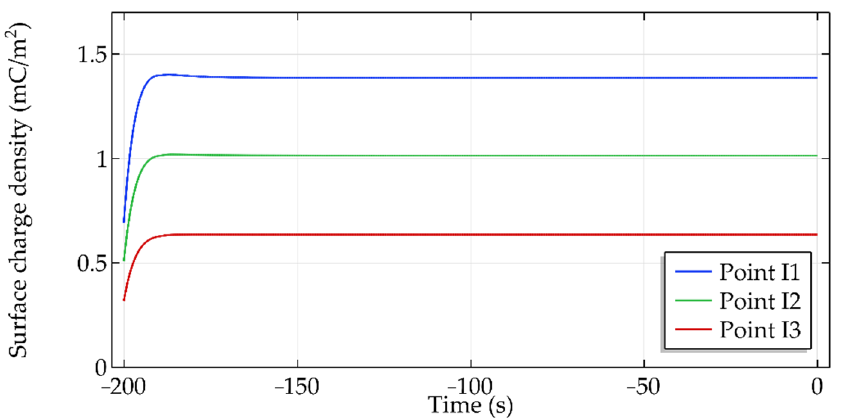
Figure 3. Surface charge density (mC/m 2 ) in points I 1 , I 2 and I 3 (Figure 1) as a function of time (s) in the 2nd case under applied 20 kV DC voltage.